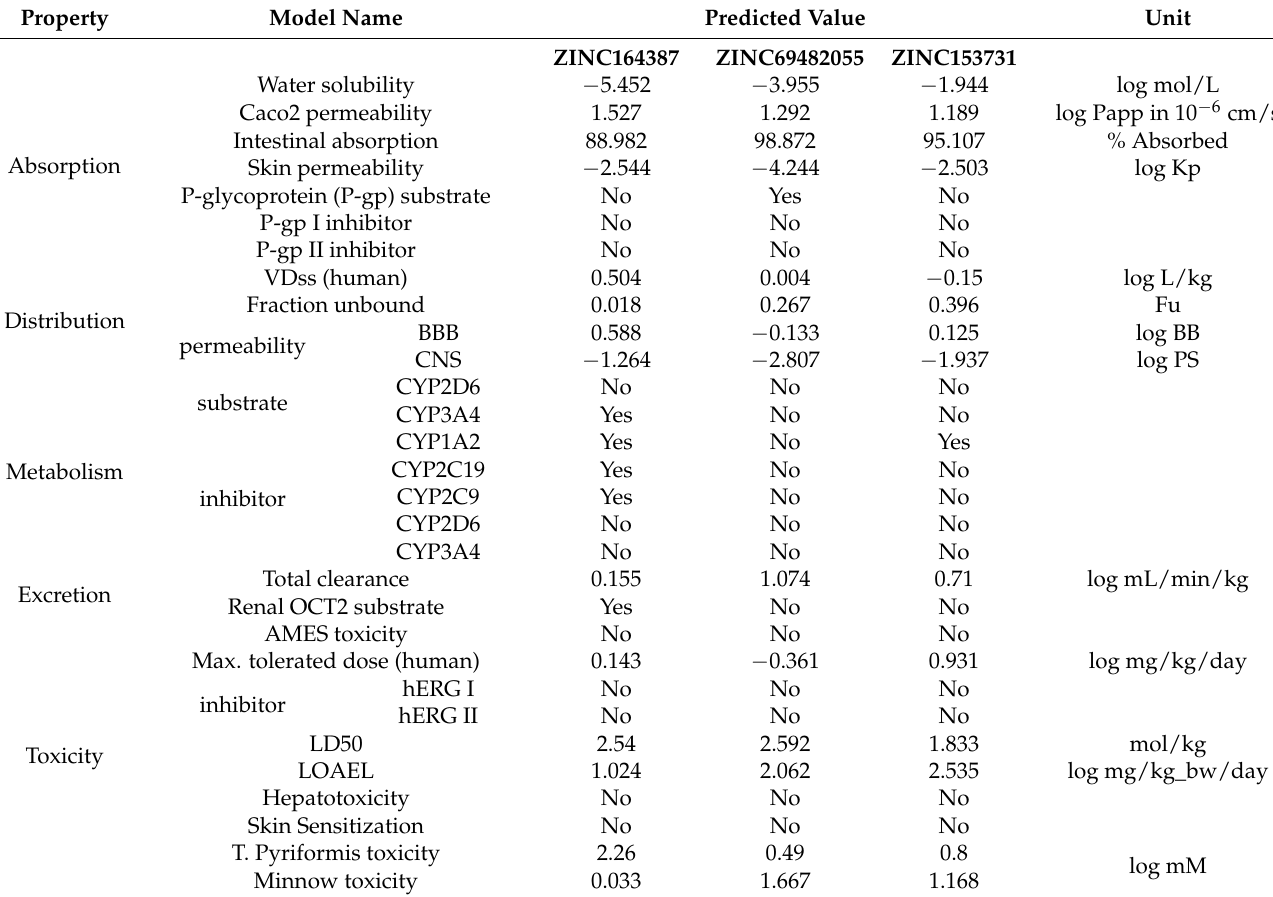
Table 2. ADMET prediction of the top-scored natural